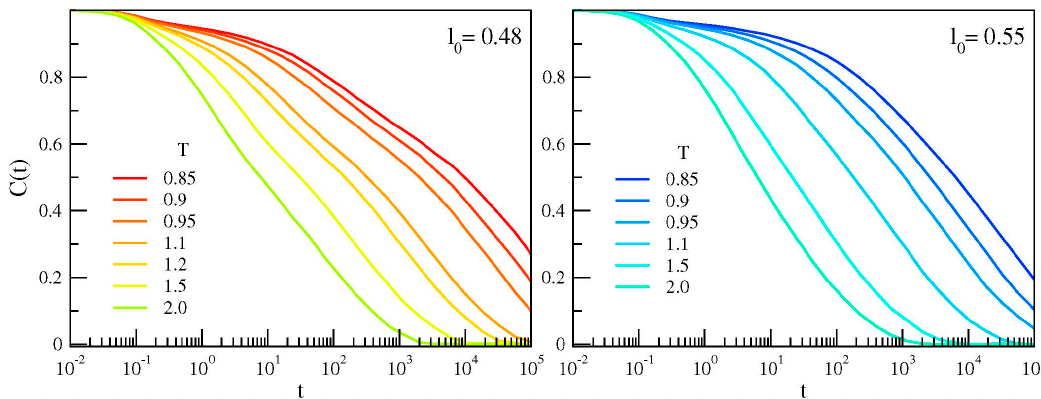
Figure 2. Temperature dependence of the bond correlation function of the chains with different bond length. If l 0 = 0.48, a two-step decay — evidencing two distinct relaxations — is observed.